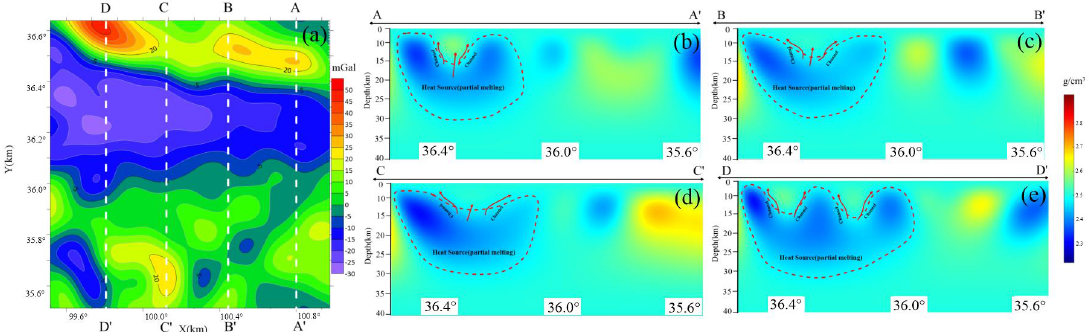
Figure 7. Cross sections of 3-D density model ( b – e ) along profiles indicated on ( a ).